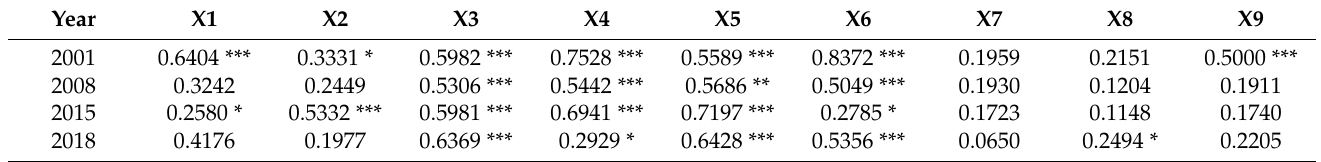
Table 2. Results of factors affecting entrepreneurial activities in the Yangtze River